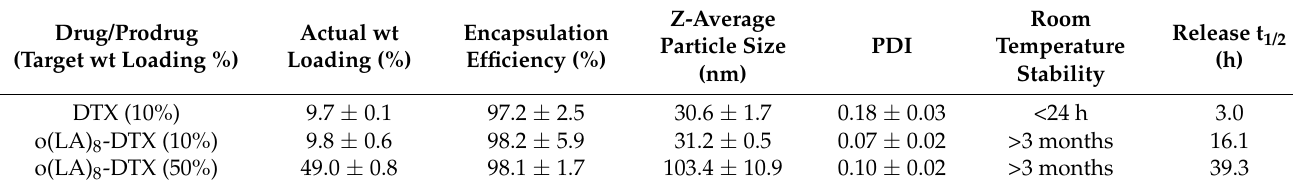
Table 1. Physicochemical properties of DTX- or o(LA) 8 -DTX-loaded PEG- b -PLA micelles prepared by thin film hydration method (n = 3; mean ± standard deviation (SD)).